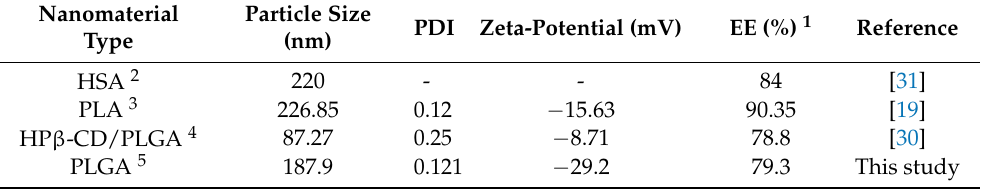
Table 3. Physicochemical characteristic comparison with other FST